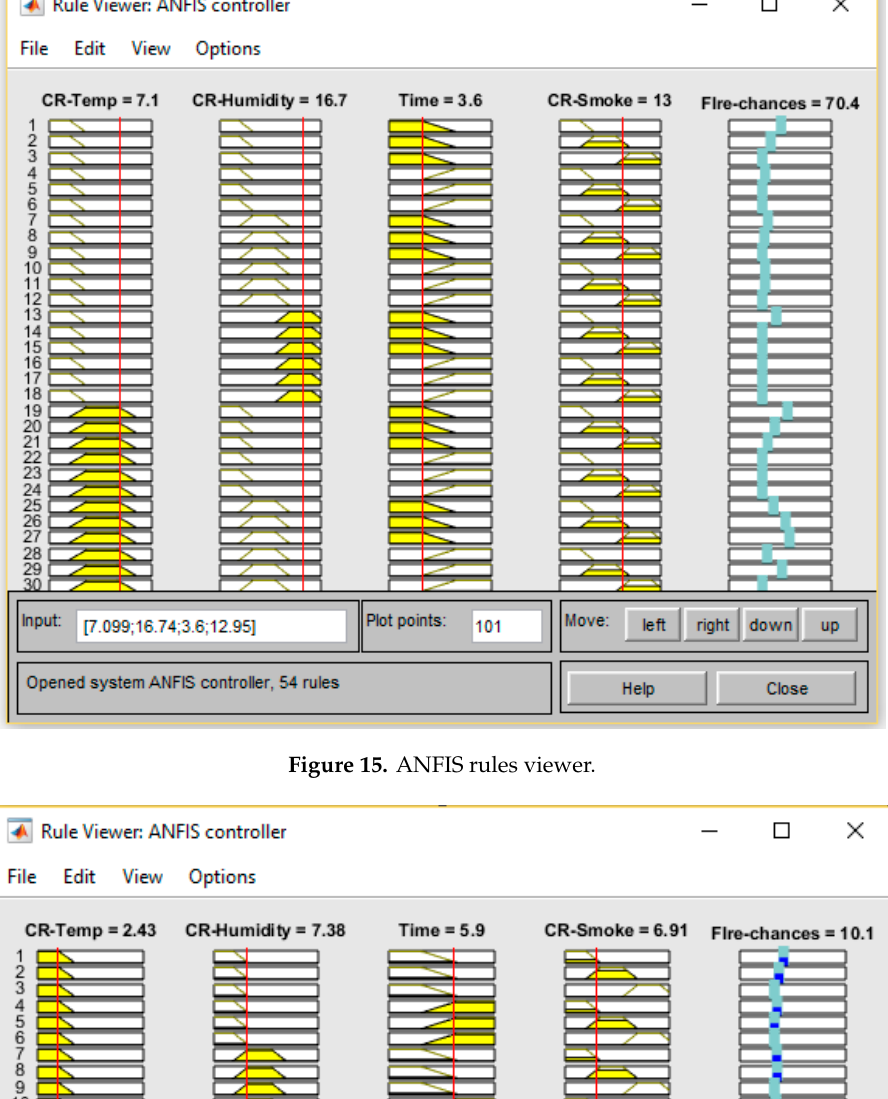
Figure 15. ANFIS rules viewer.